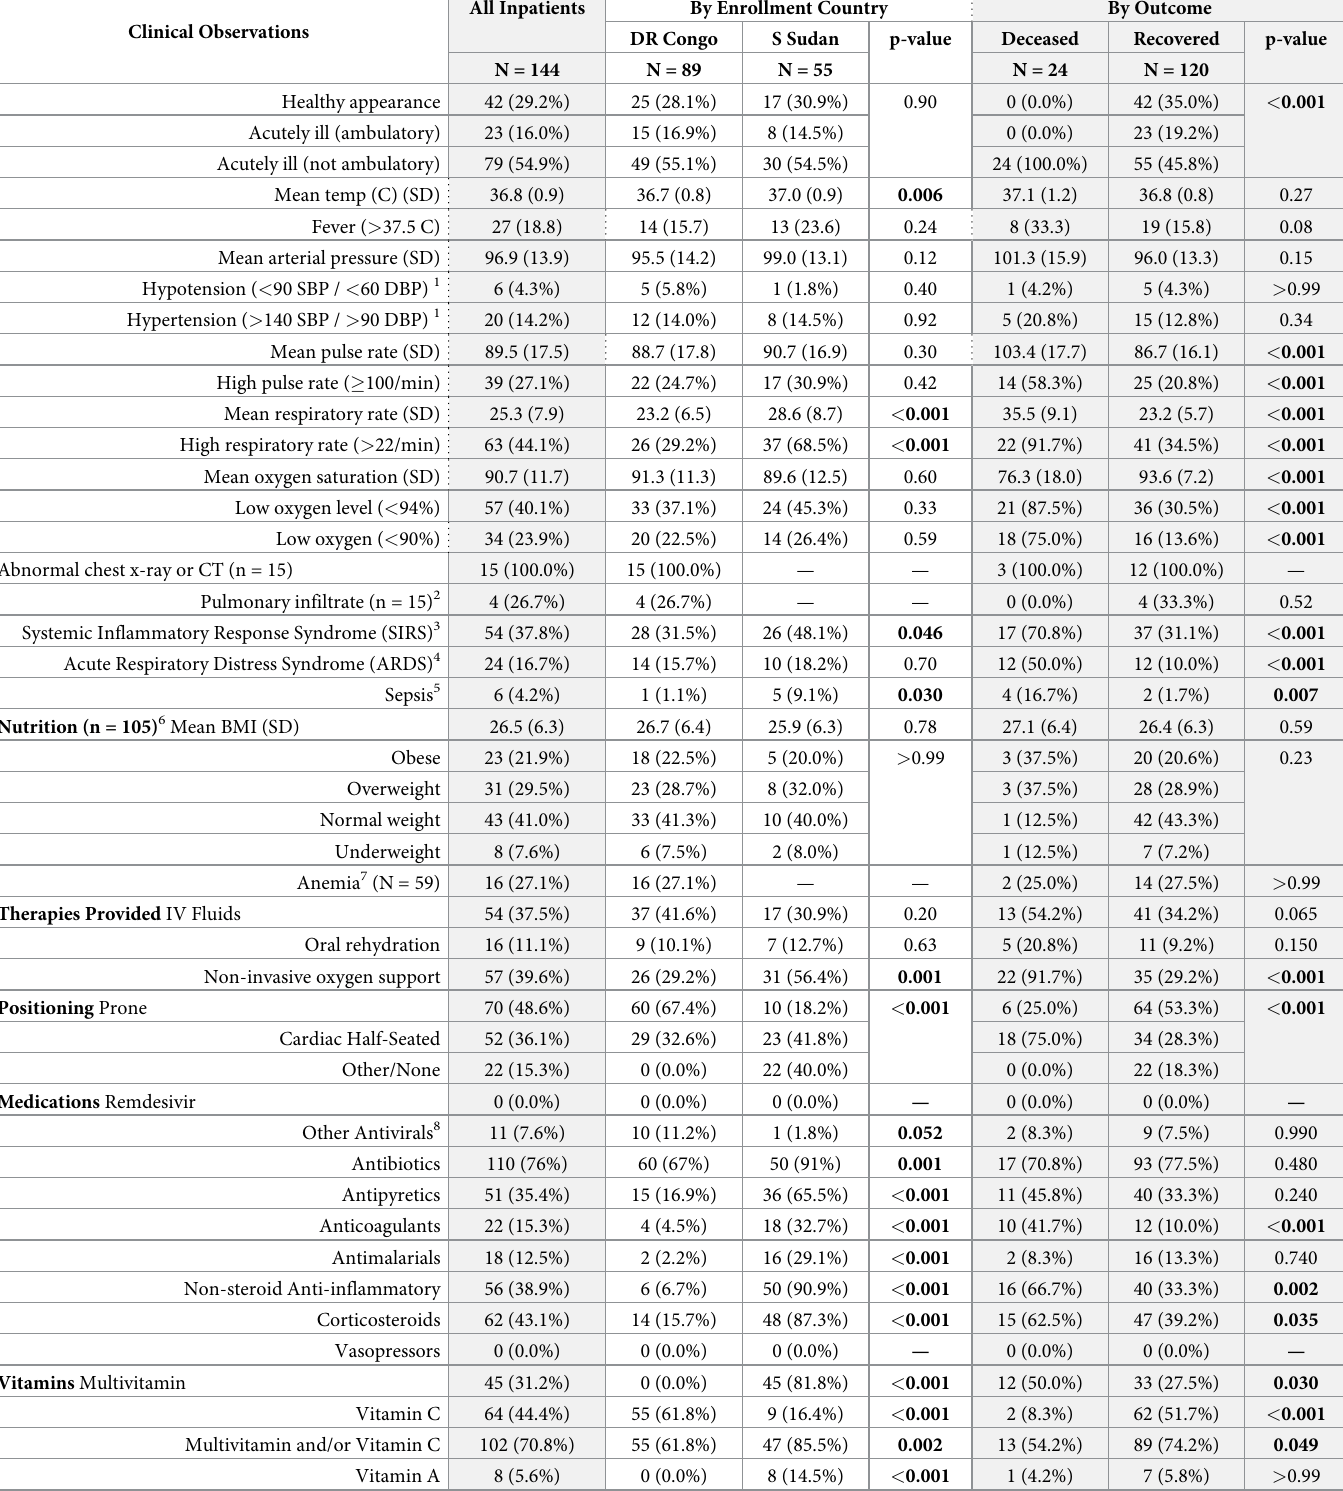
Table 2. Clinical observations, therapies and medications at admission (within 24 hours of admission). Clinical